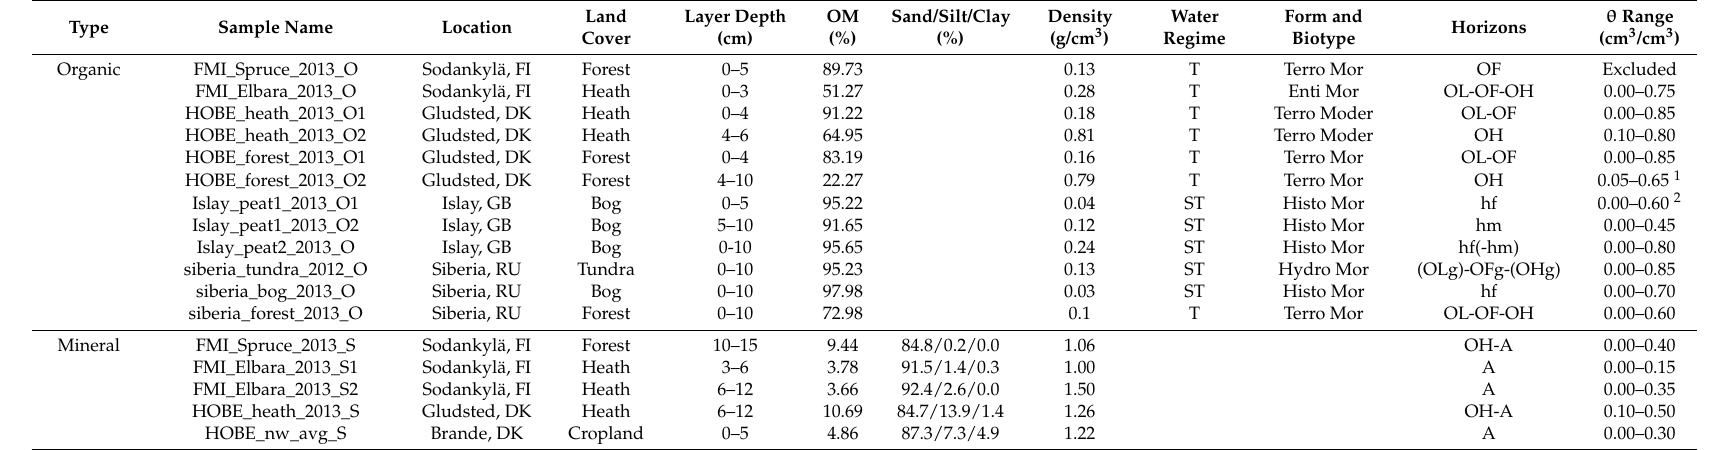
Table 1. Overview of the samples used for L-band permittivity measurements collected from organic and mineral horizons: Sample name, location, land cover and layer depth of sample collection. Soil properties include organic matter (OM) and texture contents and dry bulk density. Classification after the European Humus Forms Reference Base [36] includes information on the water regime (terrestrial T or semi-terrestrial ST) as well as form and biotype. Volumetric moisture content θ ranges (rounded to 0.05 cm 3 /cm 3 ) of the data available after filtering are also